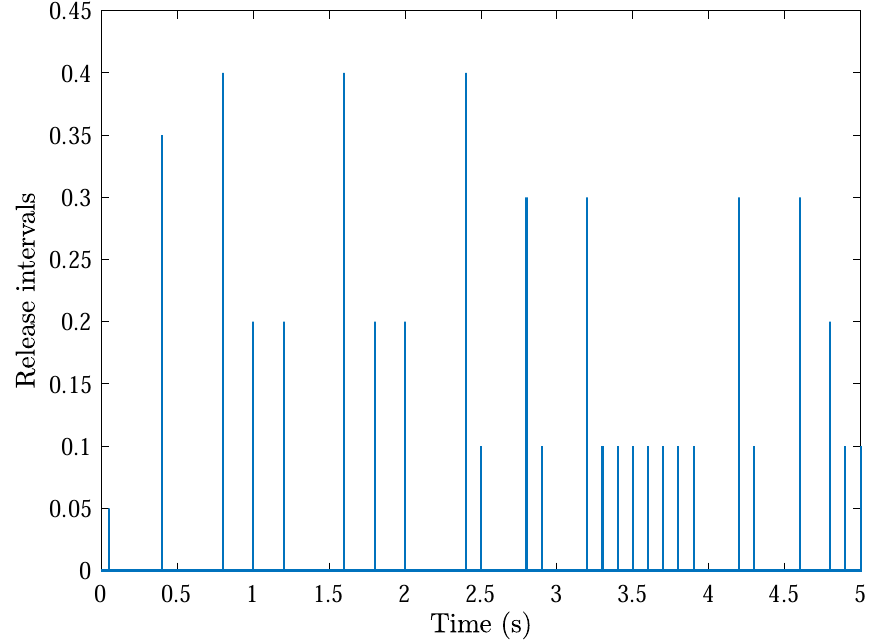
Figure 5. Event-triggered communication instants and release intervals of UAV